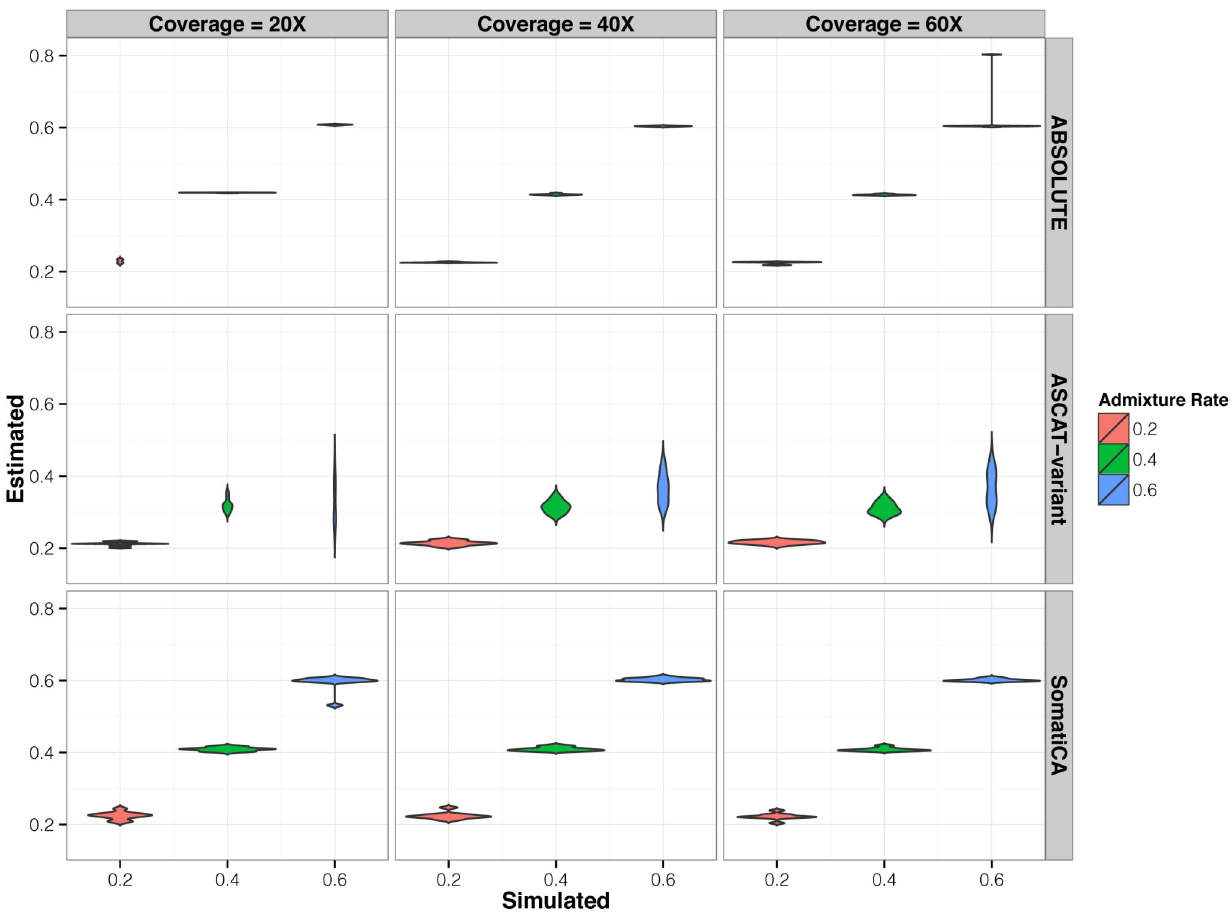
Figure 3. Boxplot of the admixture rate estimation using SomatiCA, ABSOLUTE and ASCAT-variant. Both SomatiCA and ABSOLUTE outperforms ASCAT-variant. SomatiCA achieves comparable performance as ABSOLUTE with few constraints and less computational burden.